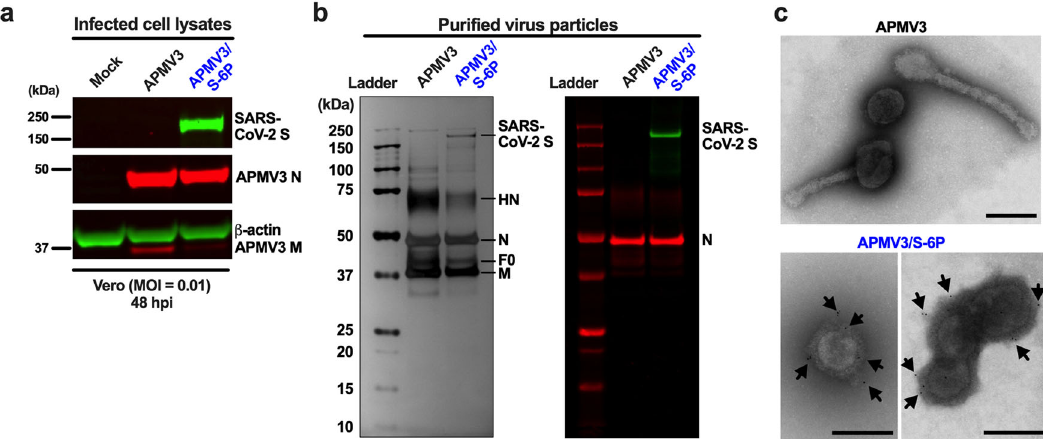
Fig. 2 Expression of virus proteins and incorporation of the SARS-CoV-2 S protein into the vector particles. a Viral protein expression in Vero cells. From the experiment described in Figs. 1e, f, one additional replicate well of Vero cells per virus, which had been infected with an MOI of 0.01 PFU/cell of the indicated virus, was harvested at 48 hpi, and cell lysates were prepared and analyzed by SDS-PAGE under reducing and denaturing conditions. The APMV3 N and SARS-CoV-2 S protein bands were visualized by Western blotting using primary rabbit anti- APMV3 serum and goat anti-SARS-CoV-2 S serum, followed by incubation with IRDye-conjugated secondary antibodies and infrared imaging (see Methods). A mouse anti- β -actin antibody was included to provide a loading control. Panels were derived from the same gel (shown in supplemental Fig. 5). b , c Incorporation of the SARS-CoV-2 S-6P protein into the vector particles. b Preparations of APMV3 and APMV3/S-6P were sucrose-puri fi ed, and three μ g of protein from each preparation were analyzed per lane by SDS-PAGE under reducing and